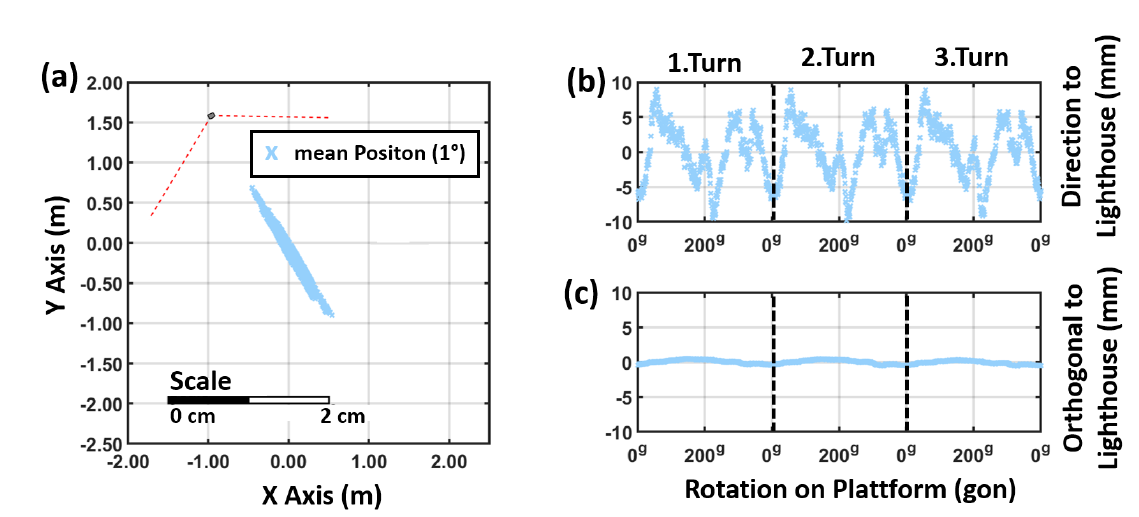
Figure 15. Horizontal position variation a VR Tracker with a single lighthouse: ( a ) horizontal plot, ( b ) in direction to the lighthouse and ( c ) in orthogonal direction. (400 g = 360 ◦